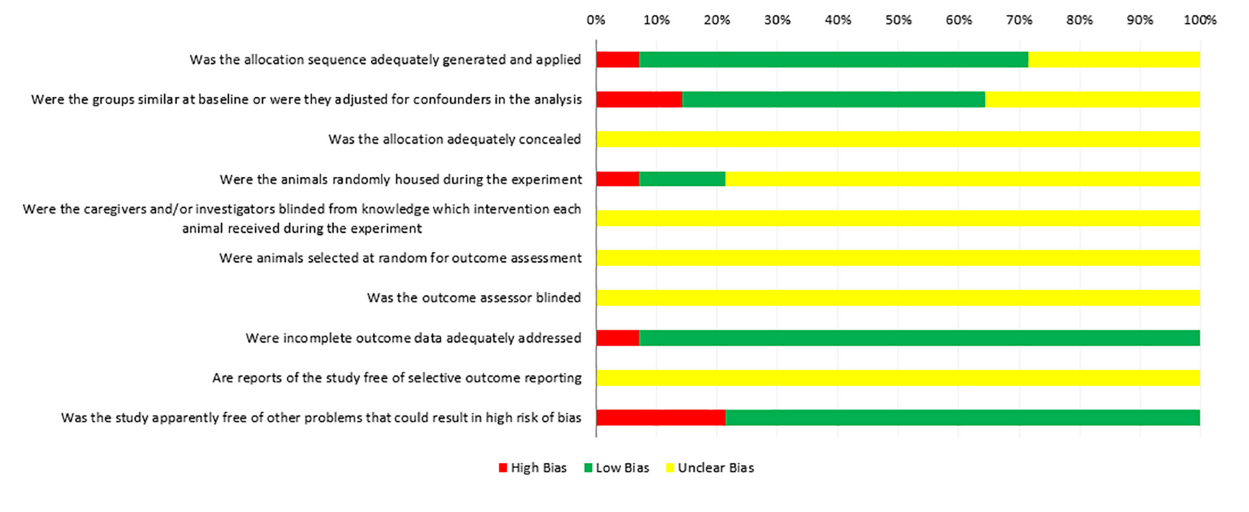
FIGURE 2 | Risk of bias of the included studies by the SYRCLE RoB